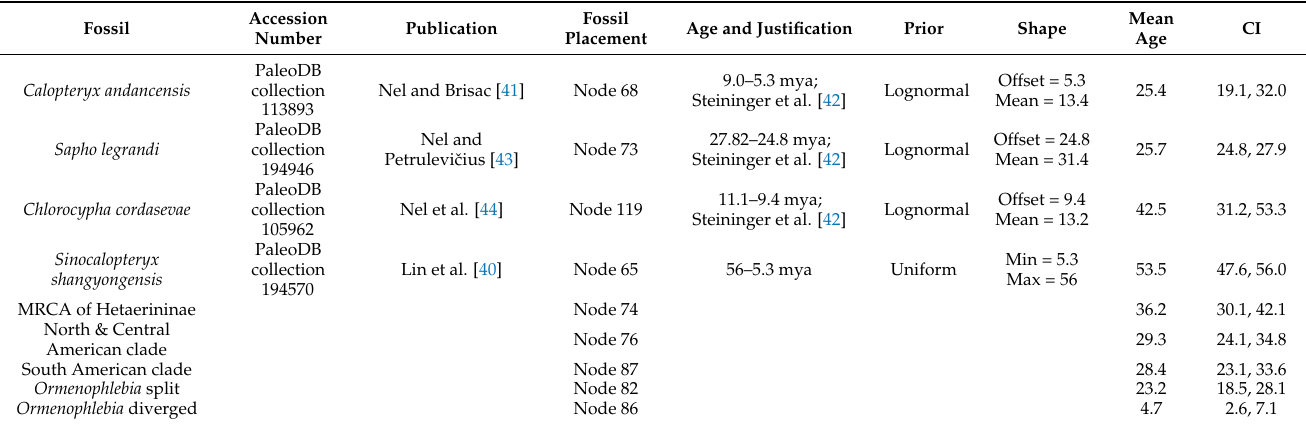
Table 1. Age of selected nodes and fossils included in analysis. See Figure S6 for numbered